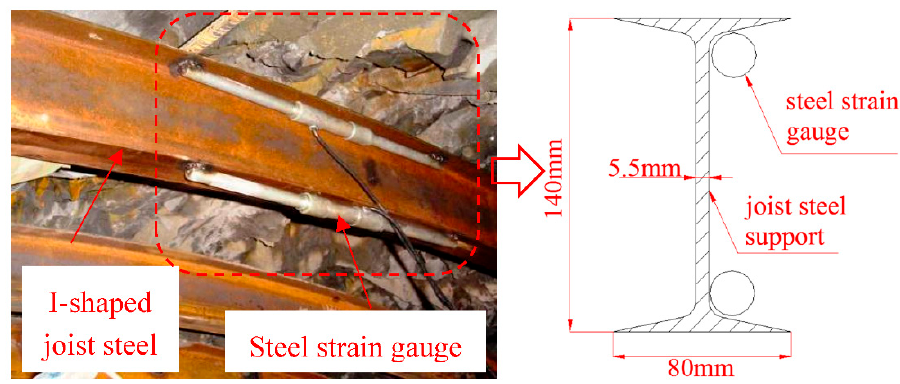
Figure 5. Rock bolt force gauge.